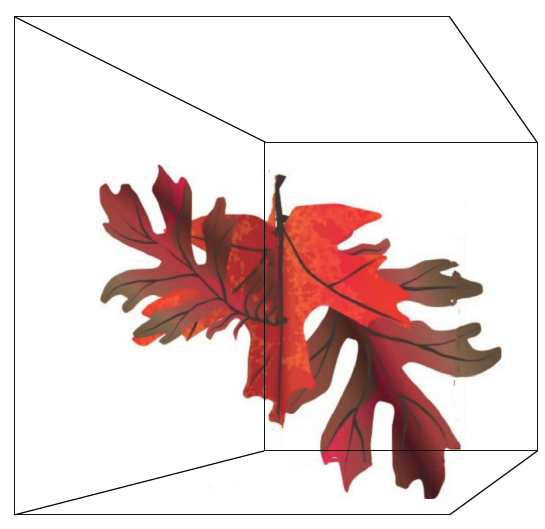
Figure 6: 3ds Max small tree